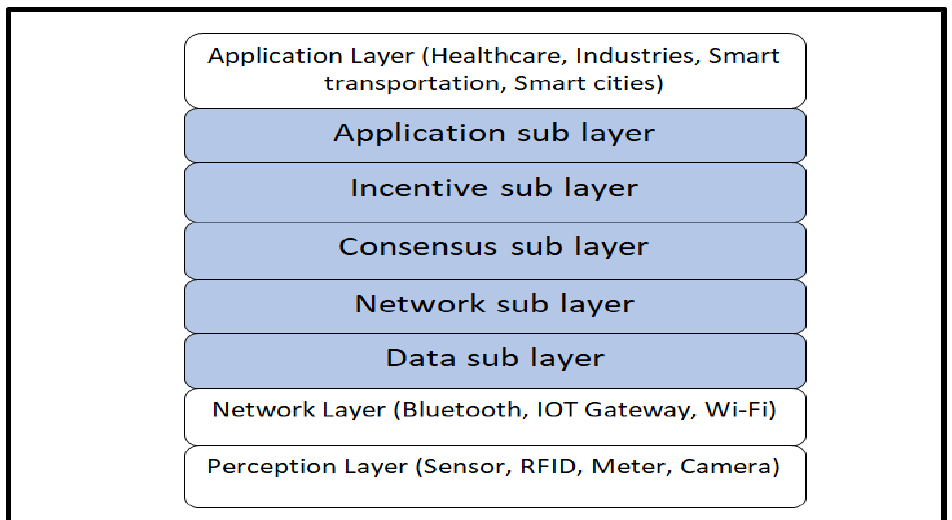
Figure 3. Blockchain-enabled IoT architecture.